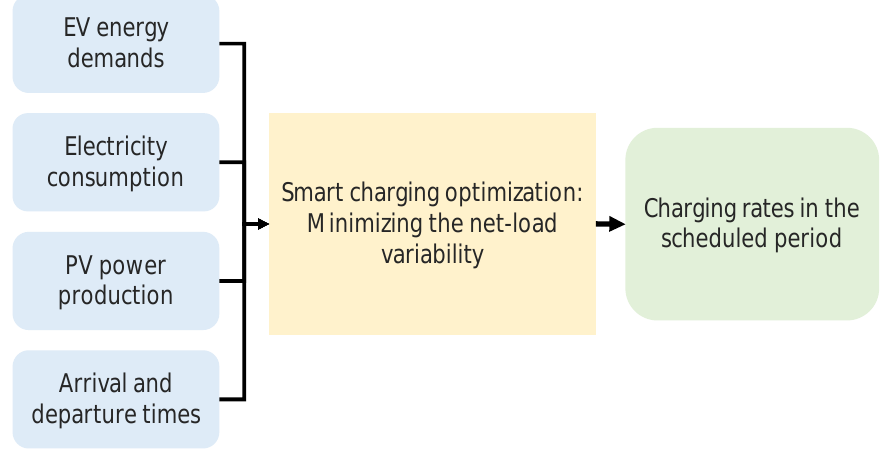
Figure 1. Overview of the smart charging